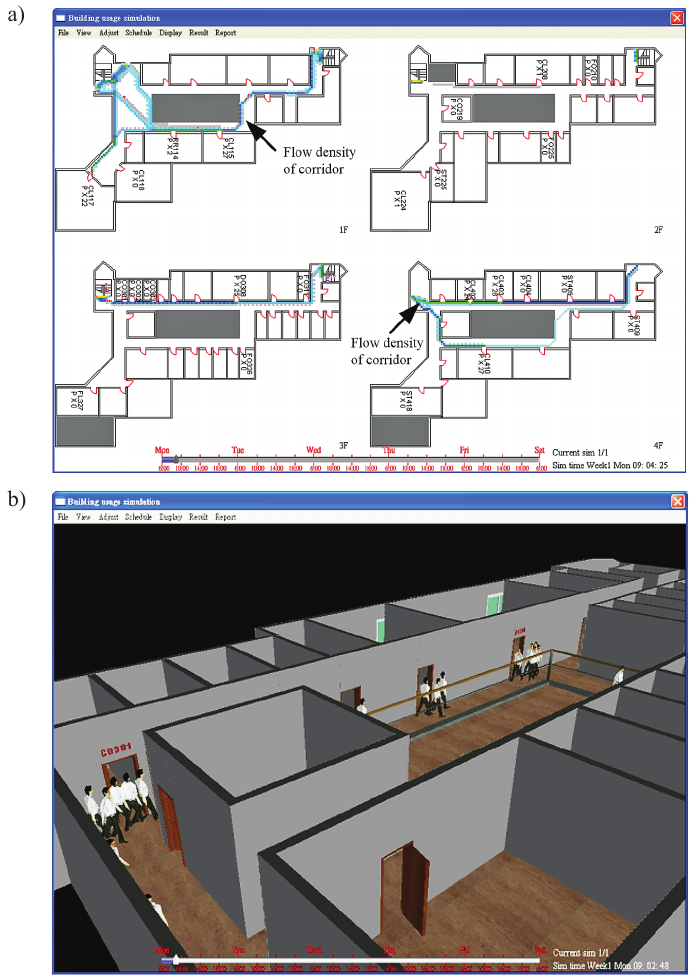
Fig. 3. Occupants’ movement trajectory: (a) 2D animation, (b) 3D